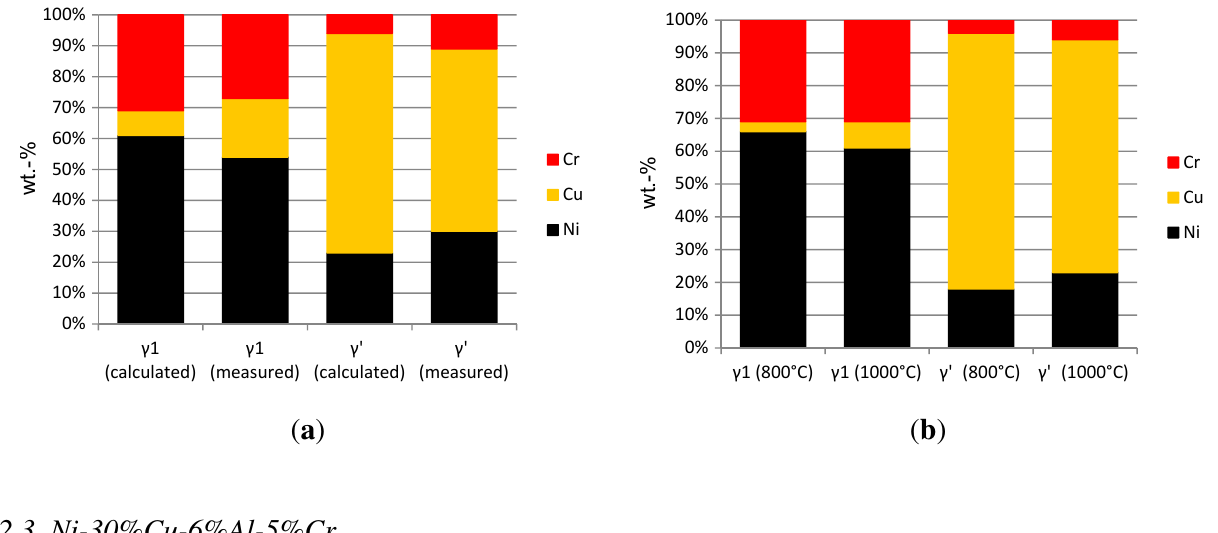
Figure 10. Phase compositions of the alloy Ni-30 Cu-22%Cr: measured with EDX and calculated with Thermo-Calc. ( a ) Calculated phase-compositions vs . measured compositions at 1000 ◦ C; ( b ) calculated phase-compositions at 800 ◦ C and 1000 ◦